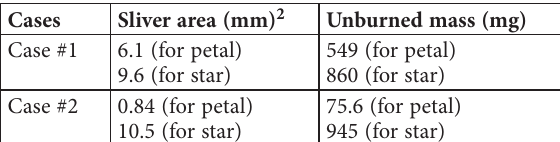
Table 4. Sliver area and unburned mass for the two